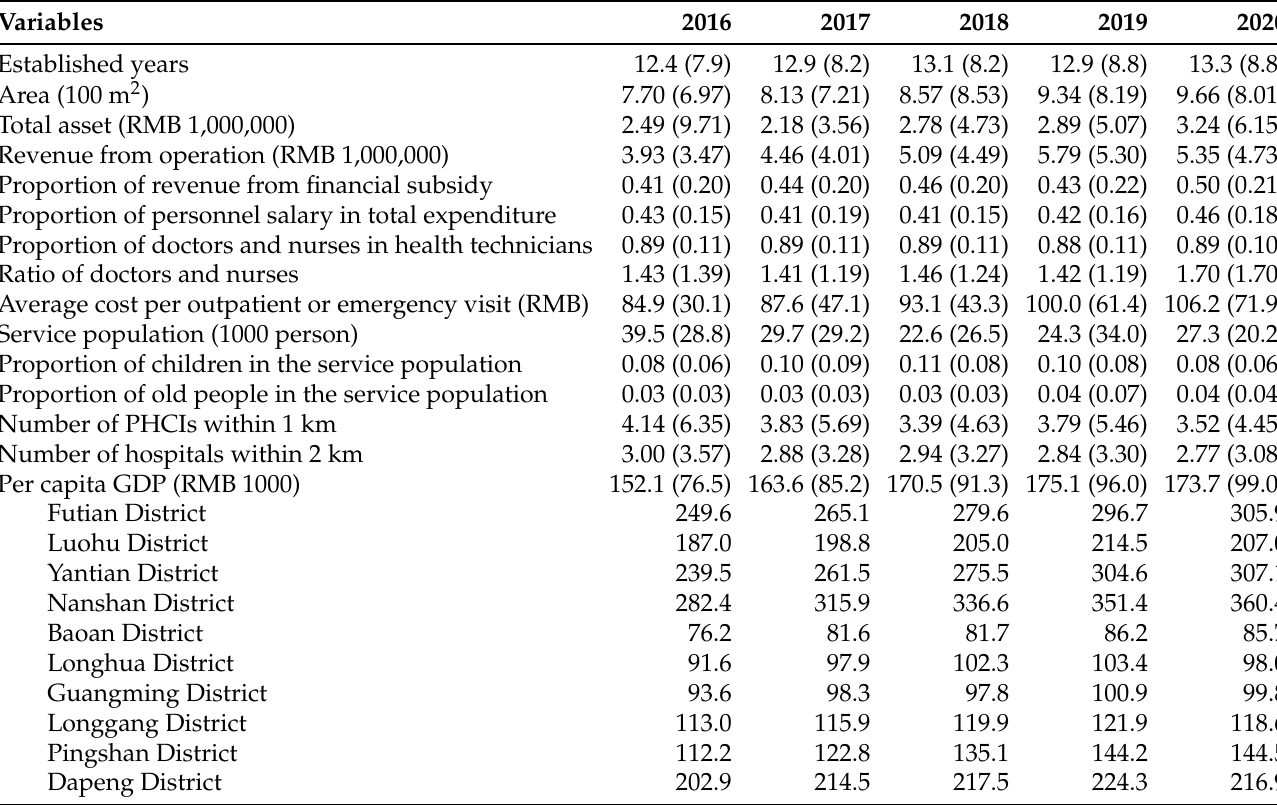
Table A1. Descriptive statistics of variables used in Tobit regression.